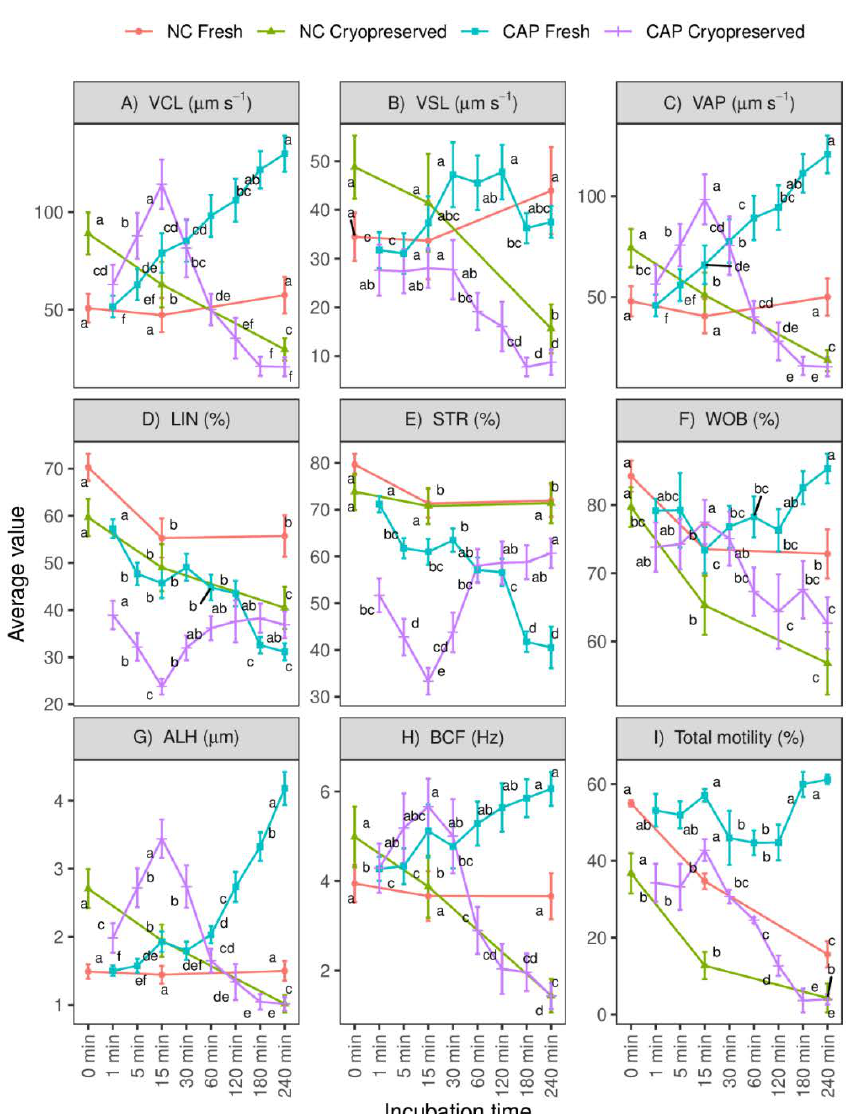
Figure 1. Overall motility and kinematic characteristics of fresh and frozen-thawed spermatozoa incubated in capacitating (CAP) and non-capacitating (NC) media over time. ( A ) VCL: curvilinear velocity; ( B ) VSL: straight line velocity; ( C ) VAP: average path velocity; ( D ) LIN: linearity; ( E ) STR: straightness; ( F ) WOB: wobble; ( G ) ALH: lateral head displacement; ( H ) BCF: beat cell frequency and ( I) total motility were the parameters evaluated. Values are expressed as means ± S.E.M (n = 12 ejaculates, 4 rams × 3 replicates). Different letters denote substantial changes ( p < 0.05) among incubation times within each type of sample.